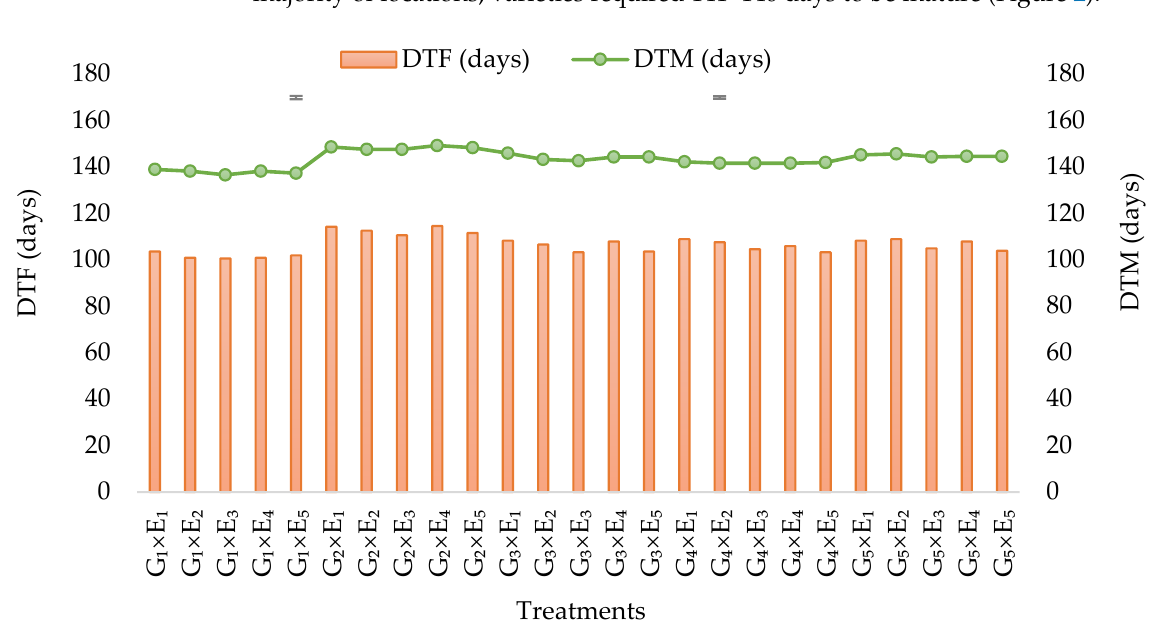
Figure 2. G × E interaction on the days to 50% flowering (DTF) and 80% maturity (DTM) of rice varieties .